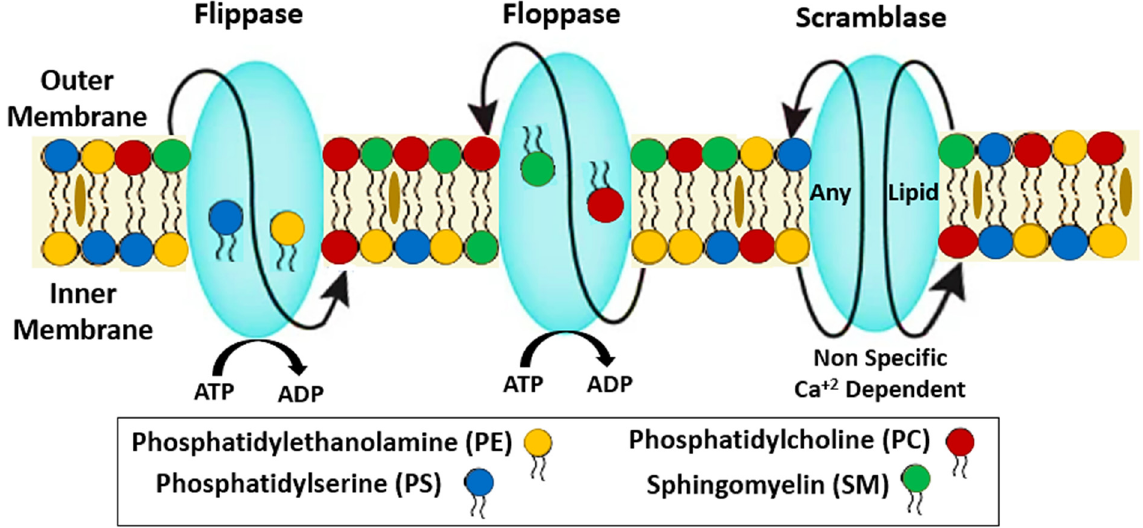
Figure 1. Schematic representation of lipid transbilayer transporters in the generation and mainte- nance of plasma membrane asymmetry. Flippases mediate ATP-dependent translocation of phos- phatidylserine (PS) and phosphatidylethanolamine (PE) from the extracellular to the inner cytosolic side. Floppases catalyze the ATP-dependent translocation of phosphatidylcholine (PC), sphingomy- elin (SM), and cholesterol to the outer leaflet. Scramblases promote Ca 2+ -activated nonspecific bidi- rectional movement.